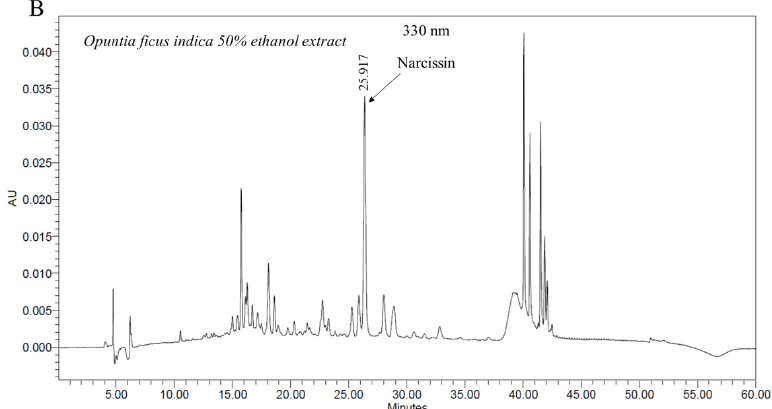
Figure 1. High-performance liquid chromatography (HPLC) chromatograms of a 50% ethanol extract of Opuntia ficus-indica (OFI) showing the structure of major compounds in the extract ( A ) Narcissin standard and ( B ) 50% ethanol extract of Opuntia ficus-indica.